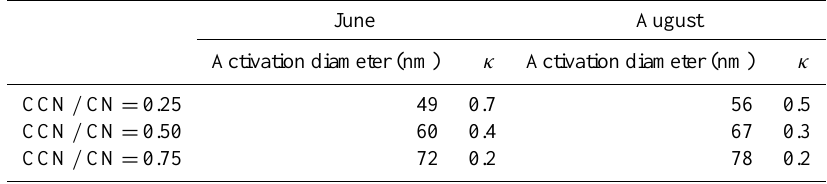
Table 1. Measured diameters when CCN / CN = 0.25, 0.50 and 0.75 and corresponding calculated κ values with Eq. (1).